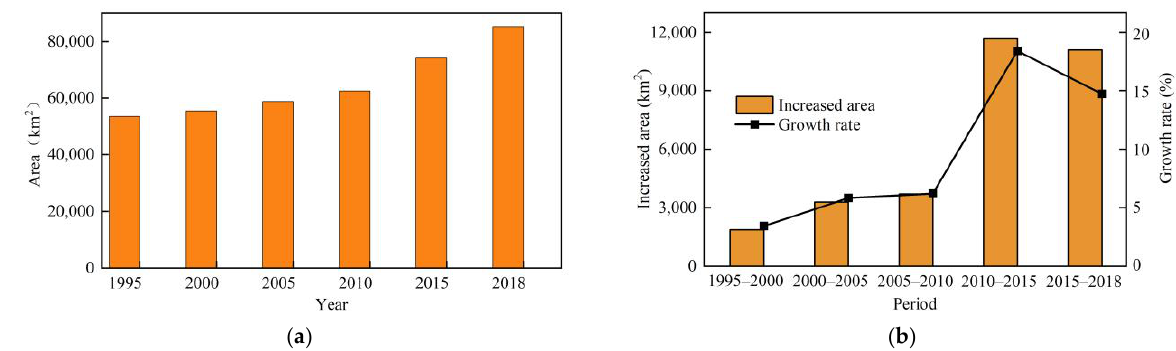
Figure 3. Change status of construction land in RBCs. ( a ) Construction land area; ( b ) growth rate of construction land.